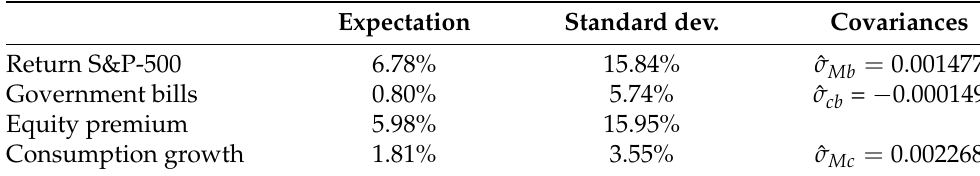
Table 1. Key US-data for the time period 1889–1978. Continuous-time compounding.